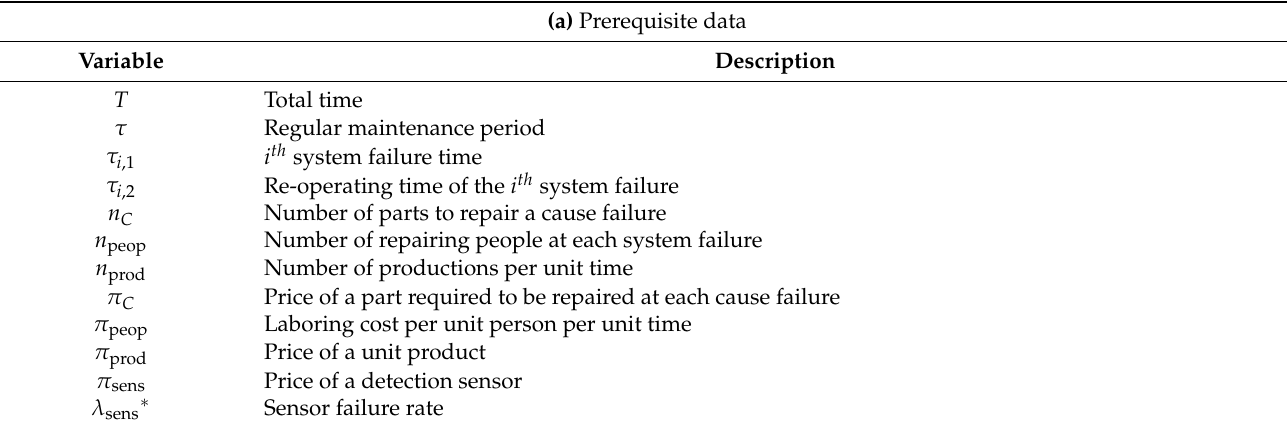
Table 1. Procedure for the EL-FMEA